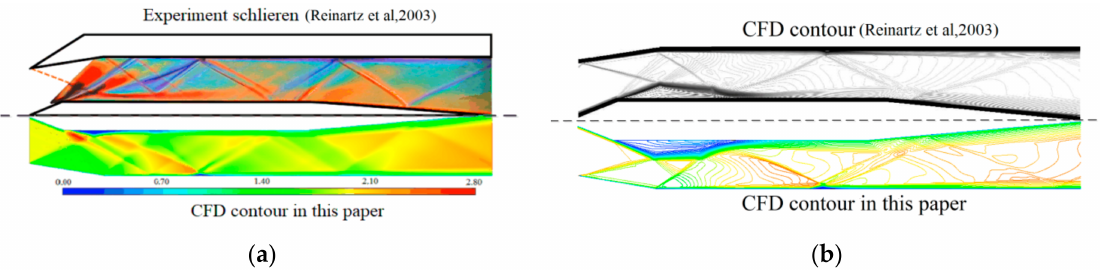
Figure 6. Comparison between the calculated results and those in reference [31]. ( a ) Ma 0 = 2.41. ( b ) Ma 0 =